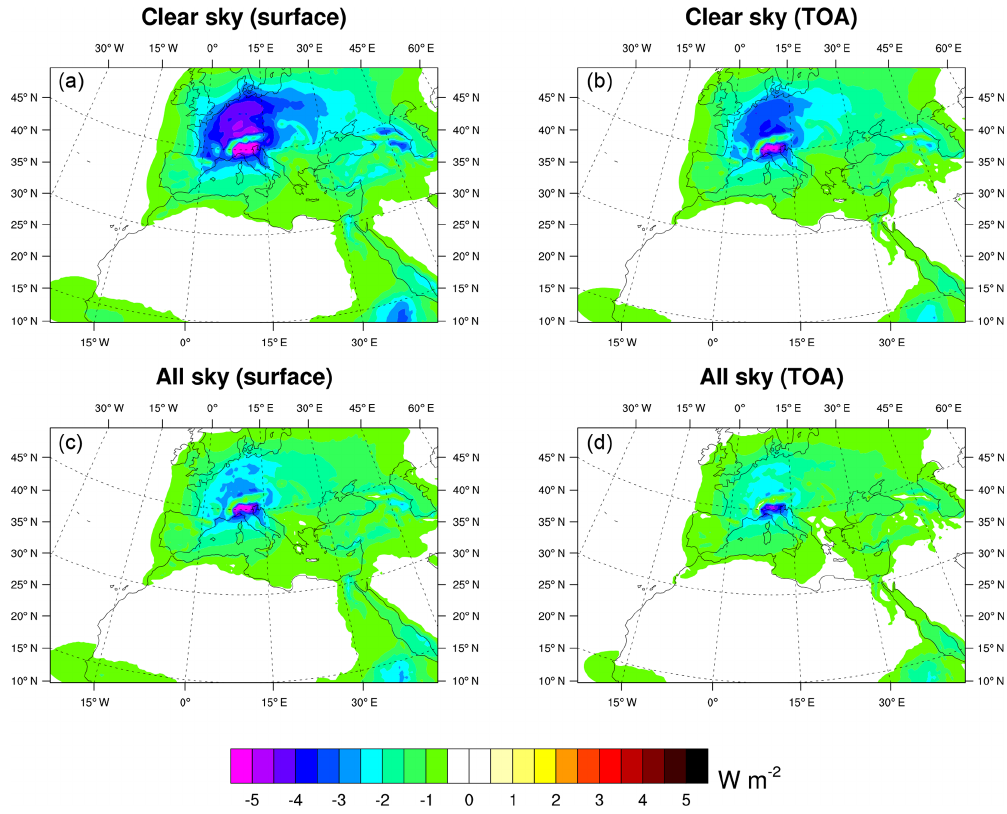
Figure 13. Clear-sky (a, b) and all sky (c, d) SW direct radiative forcing (Wm − 2 ) due to A&N aerosols at the surface (a, c) and at the top of the atmosphere, TOA (b, d) , estimated over the period 1979–2016 by difference between the REF and NIT